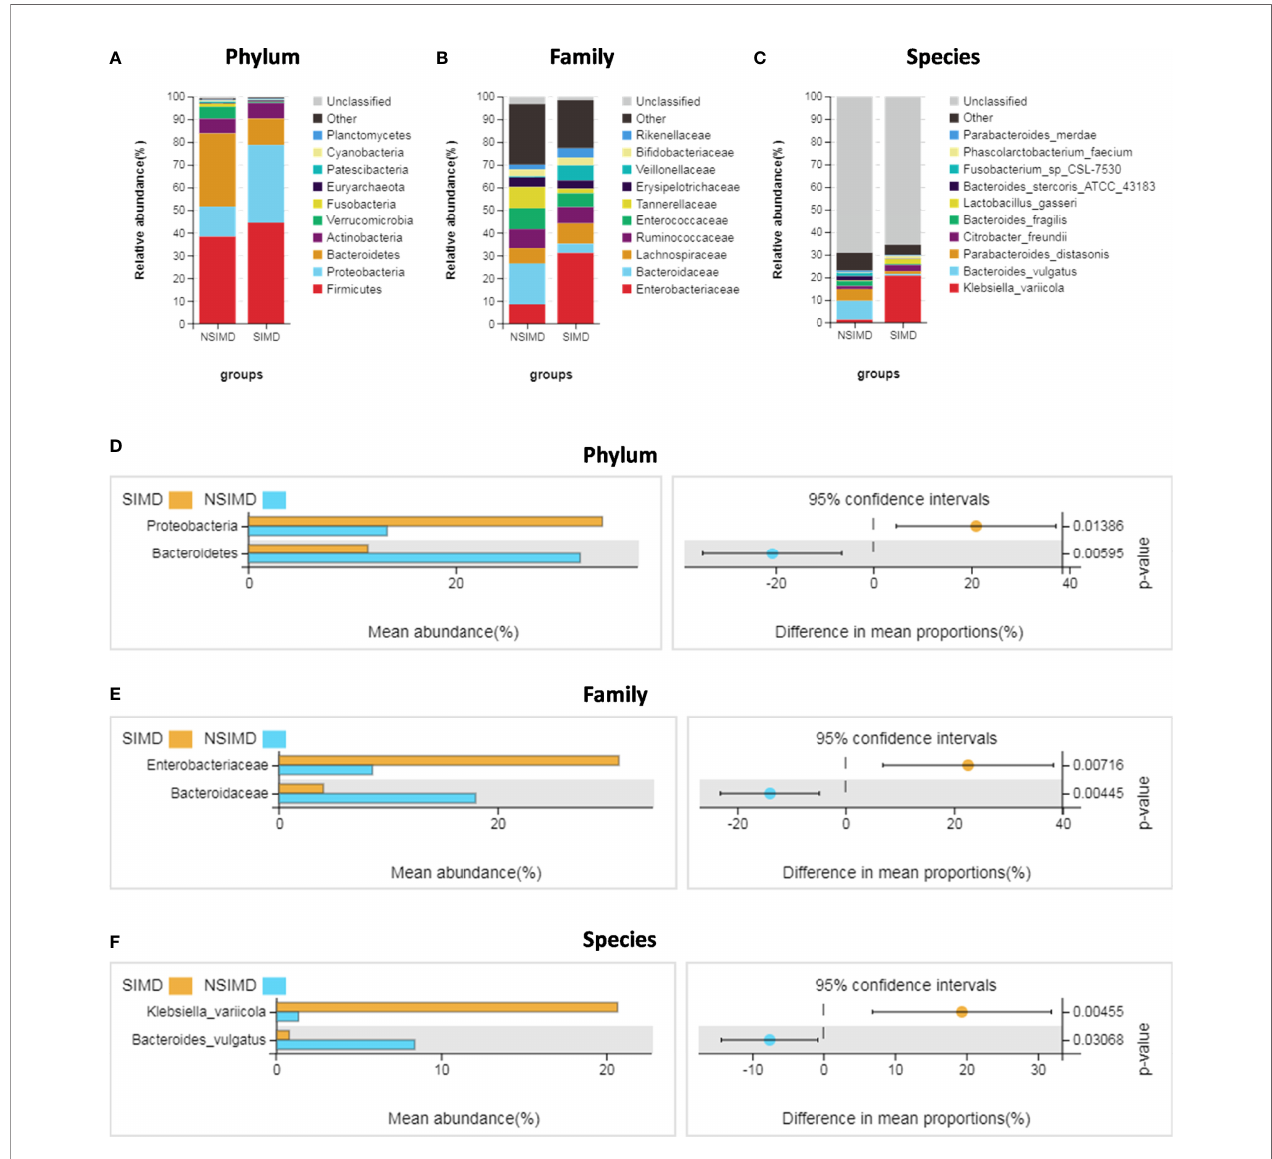
FIGURE 4 | Distribution of intestinal microbiota and species analysis of differences between two groups. (A – C) A cylindrical accumulation map at the phylum (A) , family (B) , species (C) levels. The relative abundance of the 12 most abundant bacteria in subjects. (D) At the phylum level, the SIMD group had a higher relative abundance of Proteobacteria and a lower relative abundance of Bacteroidetes. (E) At the family level, the SIMD group had a higher relative abundance of Enterobacteriaceae and a lower relative abundance of Bacteroidaceae. (F) At the species level, the SIMD group had a higher relative abundance of Klebsiella variicola and a lower relative abundance of Bacteroides vulgatus . The graph on the right shows the difference in con fi dence levels between groups. SIMD, sepsis-induced myocardial